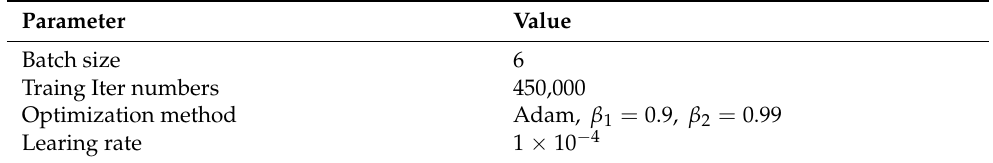
Table 3. Experimental